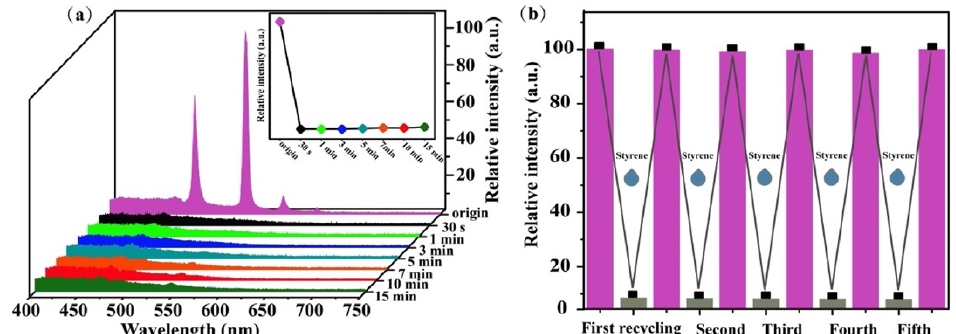
Figure 6. ( a ) Time-dependent emission spectra of the Tb-MOFs film responded to 20 µL styrene vapor; ( b ) Emission intensity of five recyclable experiments of sensing styrene, Reprinted with permission from ref. [116]. Copyright 2020 Elsevier.